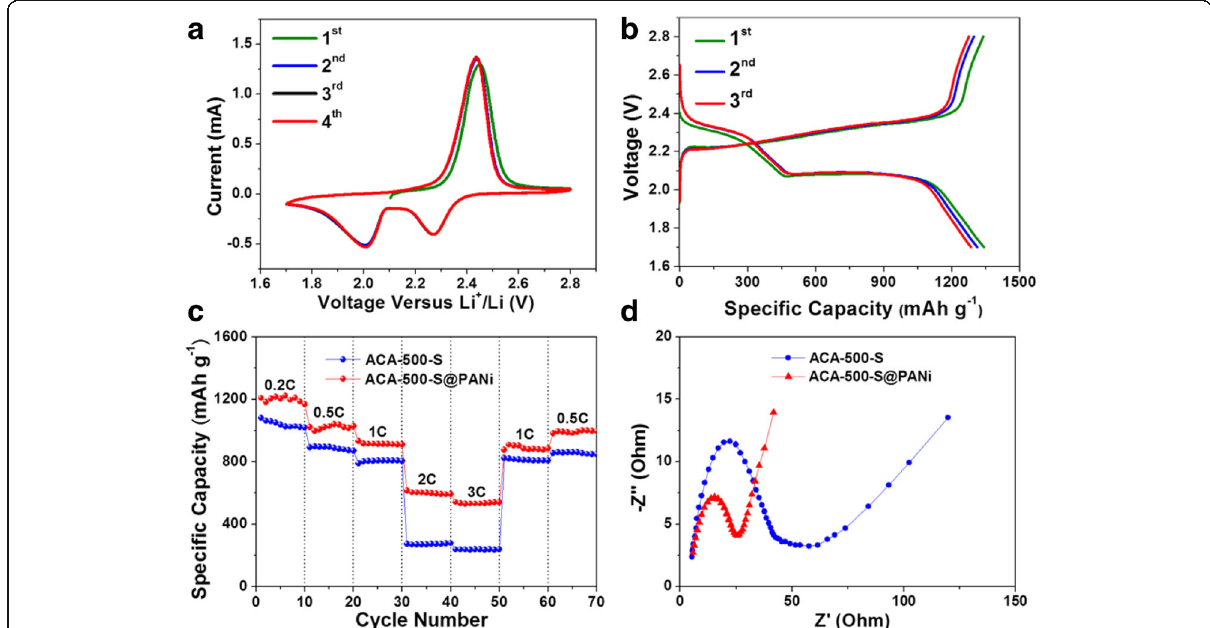
Fig. 6 a The first four cyclic voltammogram curves at 0.2 mV s − 1 and b the first three charge/discharge curves at 0.1 C of ACA-500-S@PANi cathodes; c rate performances and d EIS spectra of ACA-500-S and ACA-500-S@PANi